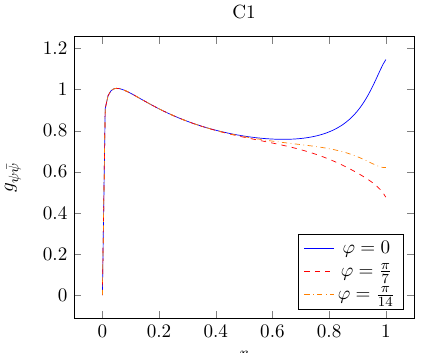
Figure 2 . Metric for constant ’ -values in the pseudo-hybrid phase of